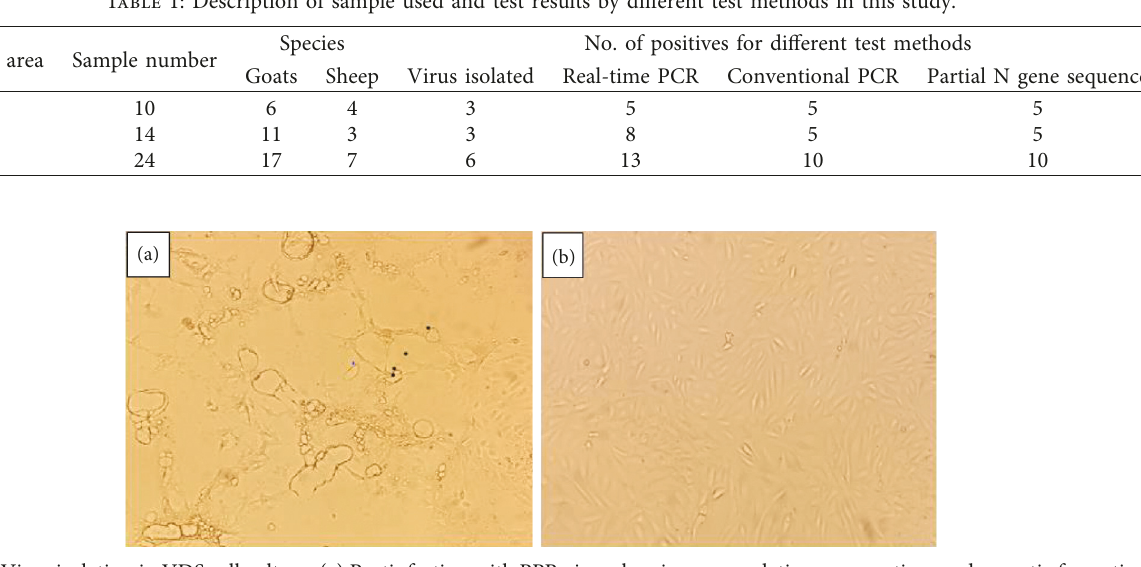
Figure 2: Virus isolation in VDS cell culture. (a) Postinfection with PPR virus showing a vacuolation, aggregation, and syncytia formation. (b) VDS cell culture as the negative control.